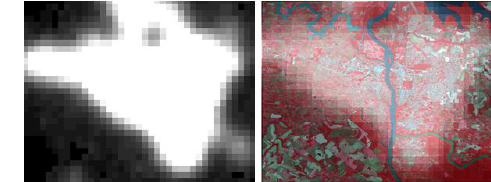
Figure 4 The nighttime image of Esther (left) and comparison chart of the nighttime image and TM